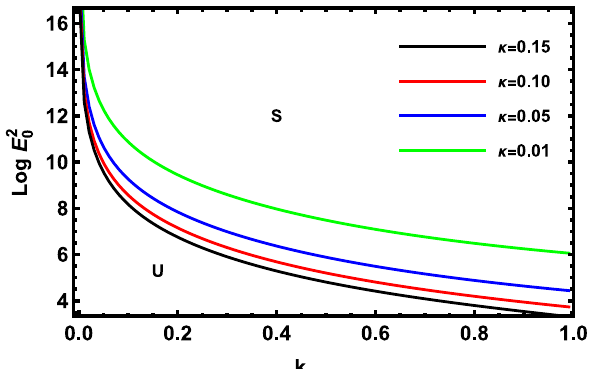
Figure 12. Displays the deviation of the growing amount versus the wave number of permeability porosity κ .